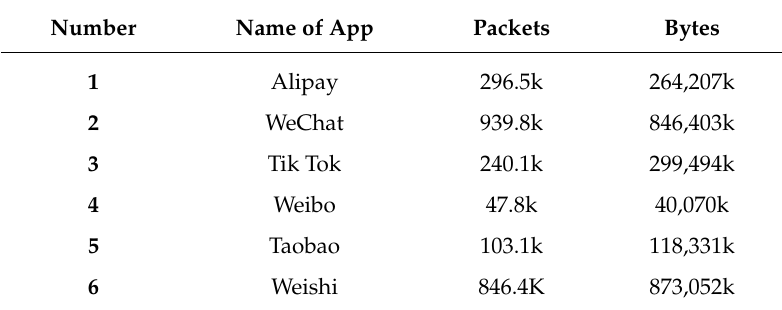
Table 2. Traffic data statistics of the apps.